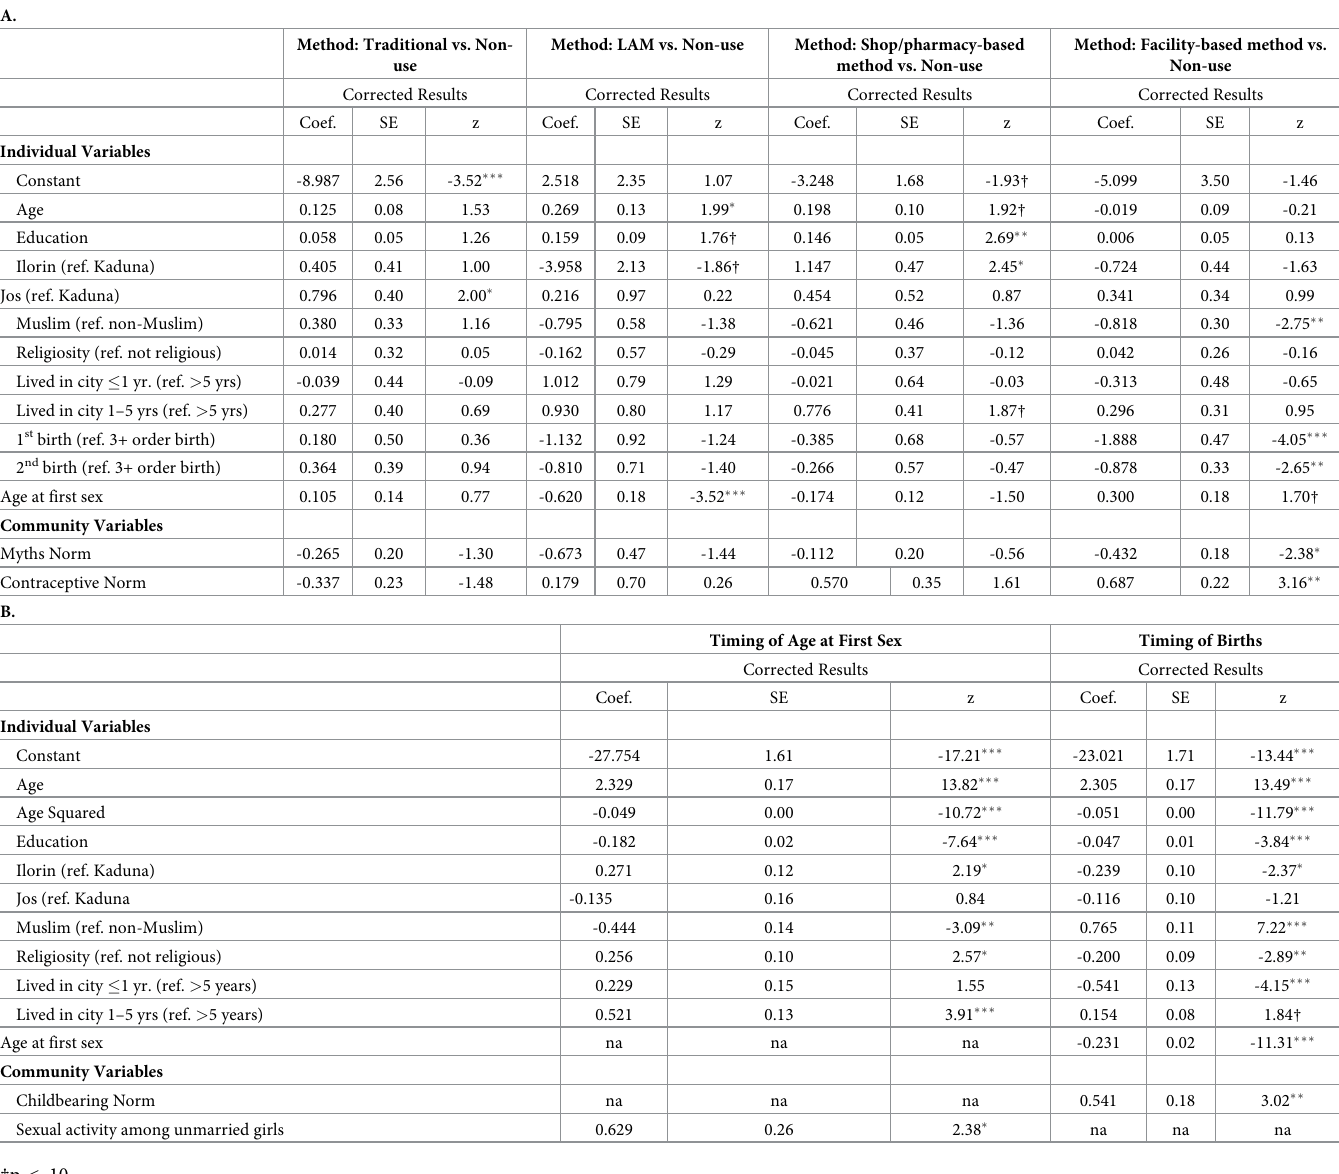
Table 3. a. Multivariate results for postpartum contraceptive method choice (Table 3a) and the timing of age at first sex and timing of births (Table 3b) from cor- rected models, Nigeria, 2017. b. Multivariate results for postpartum contraceptive method choice (Table 3a) and the timing of age at first sex and timing of births (Table 3b) from corrected models, Nigeria, 2017. A. Method: Traditional vs. Non- Method: LAM vs. Non-use Method: Shop/pharmacy-based Method: Facility-based method vs. use method vs. Non-use